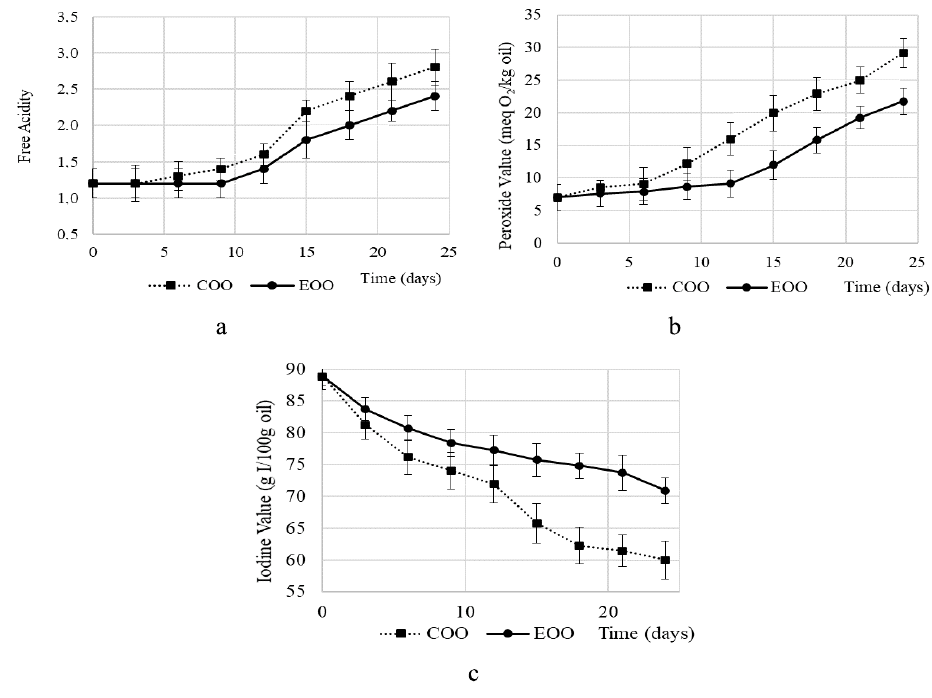
Fig. 2: FA (a), PV (b) and IV (c) of the COO and EOO under accelerated storage.